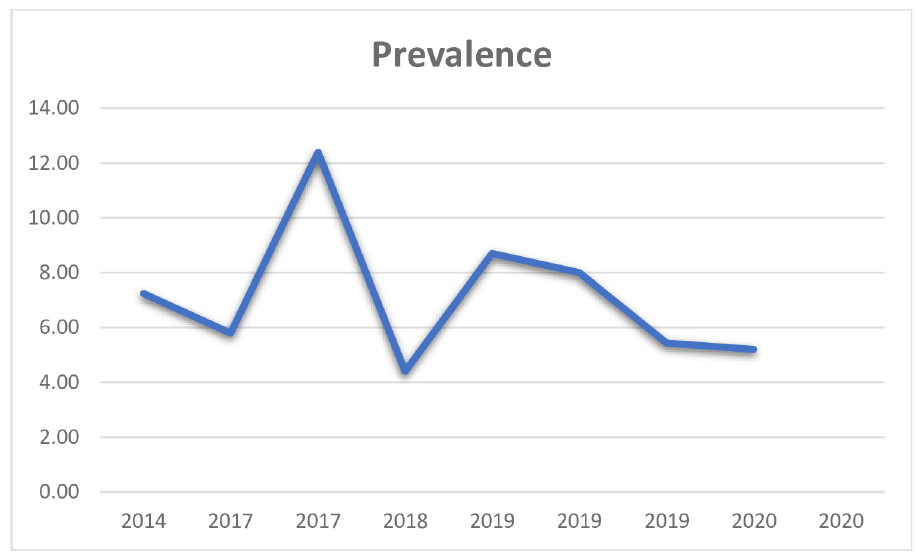
Fig 4. Trend of visual impairment among children in Ethiopia, 2021.